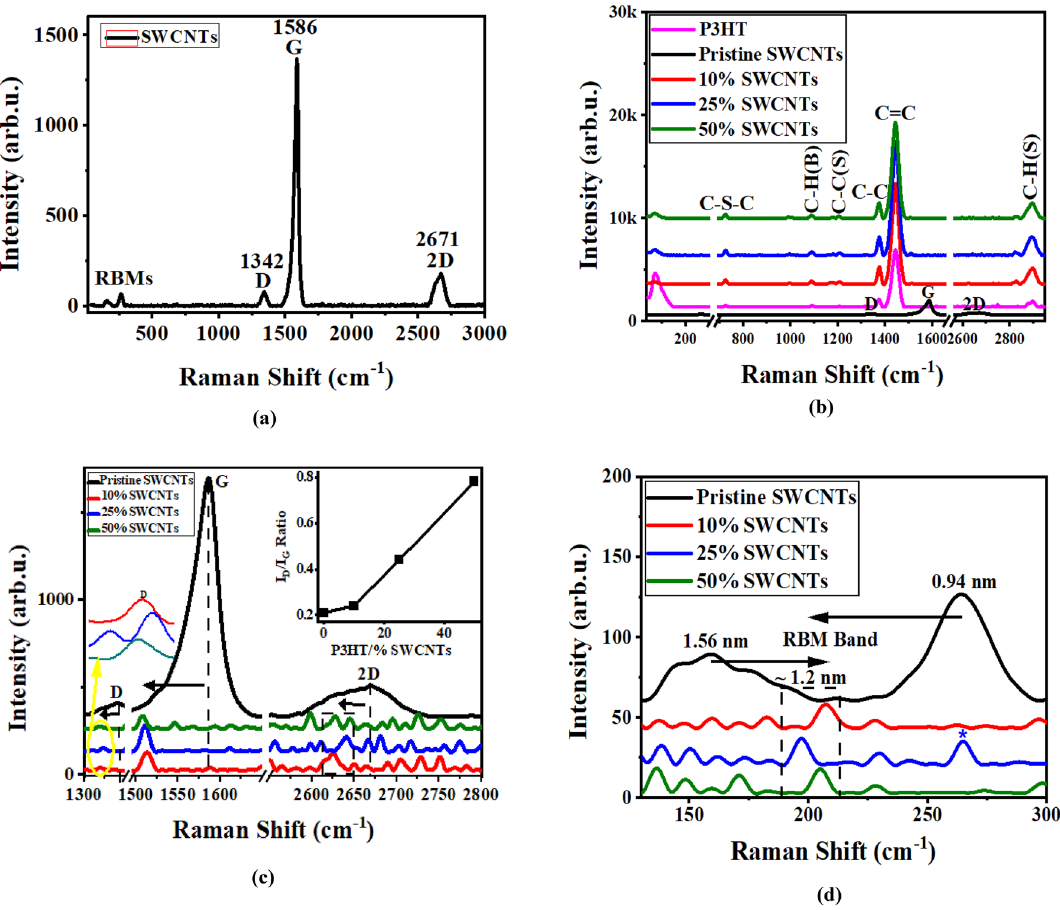
Figure 2. Raman spectra of ( a ) pristine SWCNTs, ( b ) P3HT/SWCNTs nanocomposites with different ratios of SWCNTs, ( c ) analysis of the D, G and 2D band, Inset of ( c ) presents the I D /I G ratios and ( d ) analysis of the RBMs